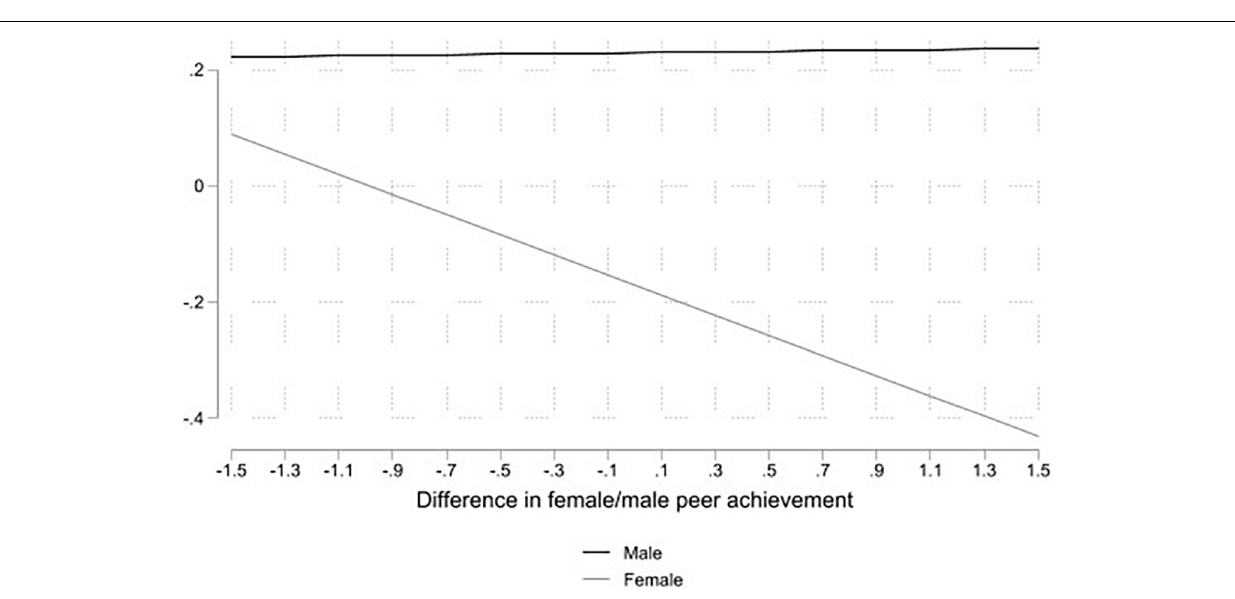
FIGURE 3 | Difference in female/male peer achievement and predicted mathematics self-concept by